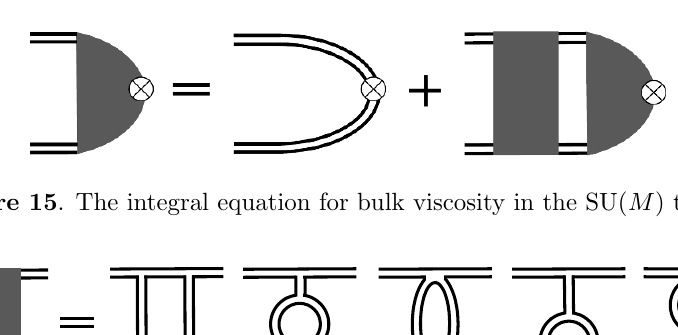
Figure 14 . One out of many vertices in ( r; a ) basis which has to be considered in the collinear splitting analysis. Shown are also di(cid:11)erent possibilities of adding a soft line between a pair of propagators with nearly pinching poles.